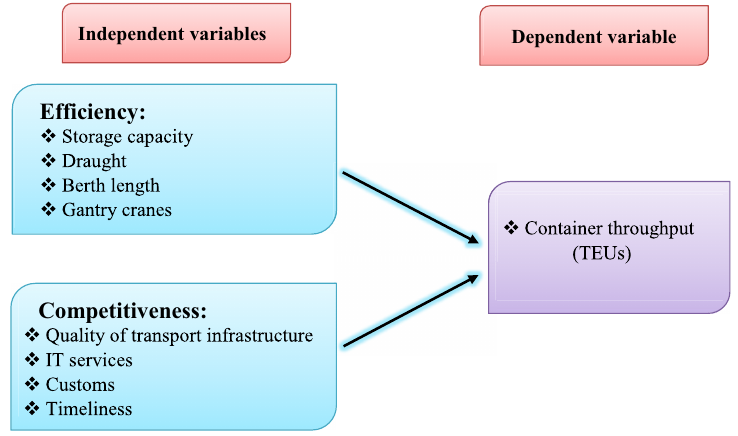
Figure 1. Research